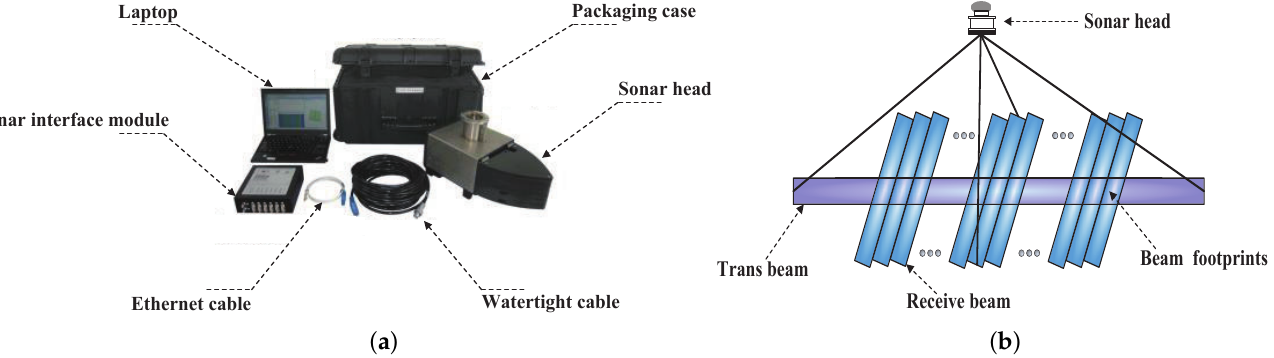
Figure 6. The HT multi-beam echo sonar structure diagram: ( a ) system composition diagram; ( b ) Mill’s cross-array sonar architecture.